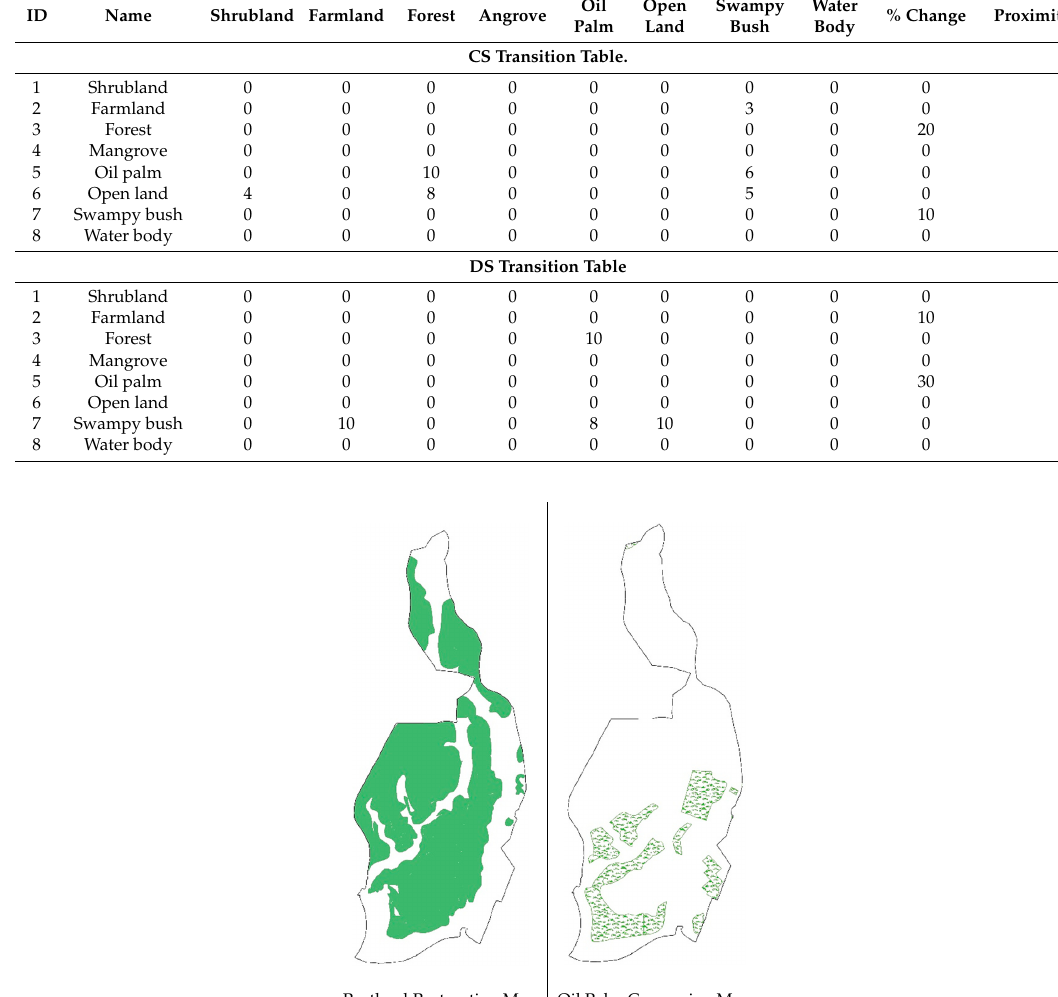
CS Transition Table.